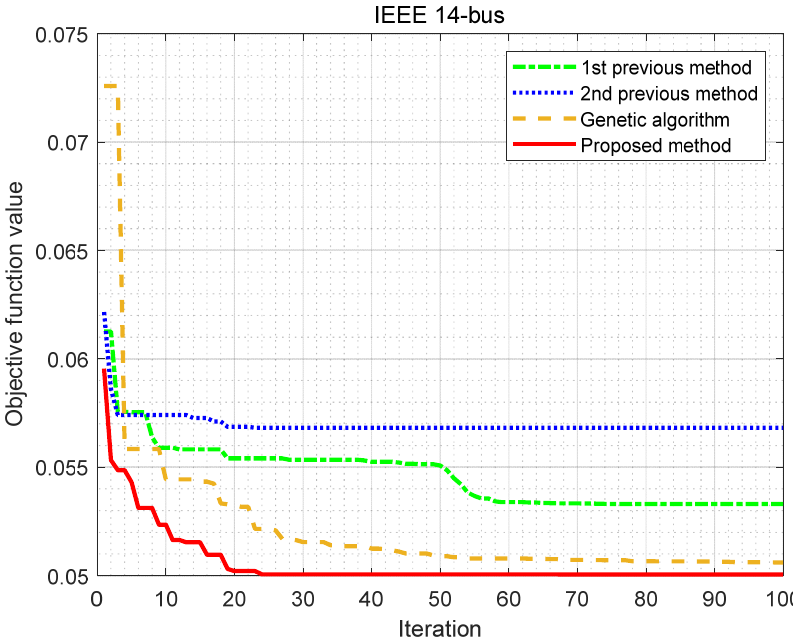
Figure 10. Convergence of the objective functions (IEEE 14-bus test feeder). Table 4. Location and capacity of DG systems for the IEEE 14-bus test feeder.